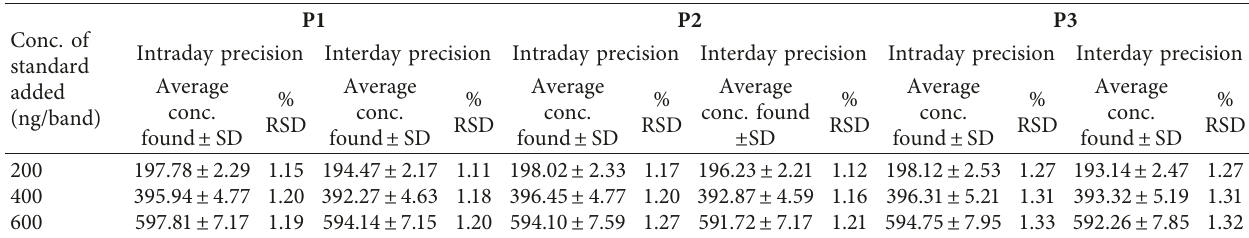
Table 7: Precision of the proposed HPTLC method ( n � 6).